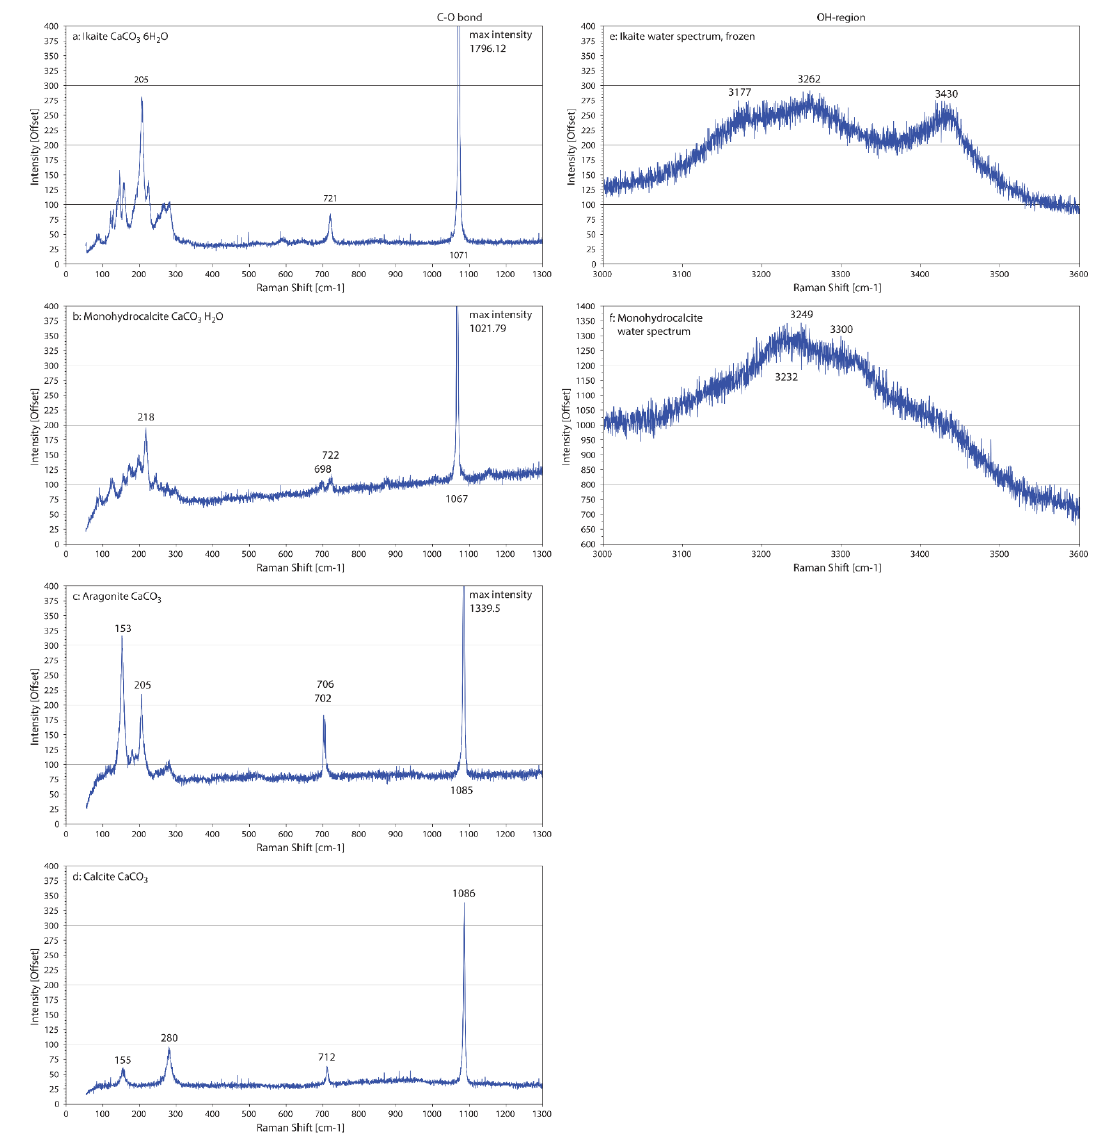
Figure 6. Results of Raman analysis of minerals of columnar origin from Ikka Fjord of ( a ) ikaite, ( b ) monohydrocalcite, ( c ) aragonite, ( d ) calcite, and the OH-region of ( e ) ikaite, and ( f ) monohydrocal- cite.